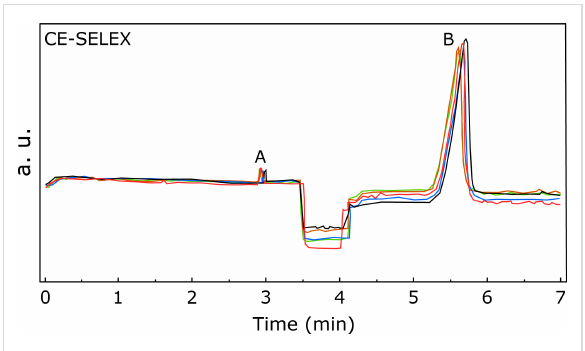
Figure 1: Representative CE electropherogram of CE-SELEX separa- tion step. Peak A corresponds to the NS1–aptamers complexes, while peak B refers to oligonucleotides that did not bind to the target and were discarded. Five runs, which are displayed by distinctly colored lines, were performed to accumulate enough DNA for PCR amplifica- tion. These runs are superimposed in the graph.